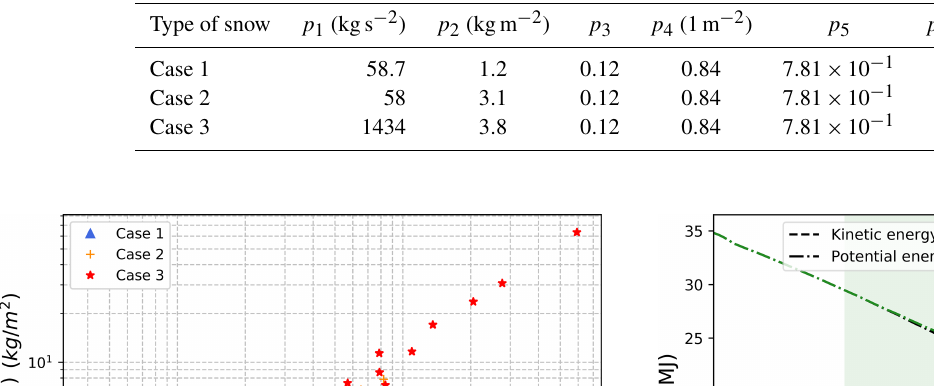
Table 3. Parameter value of the law (11) for different snow properties (Table 2).